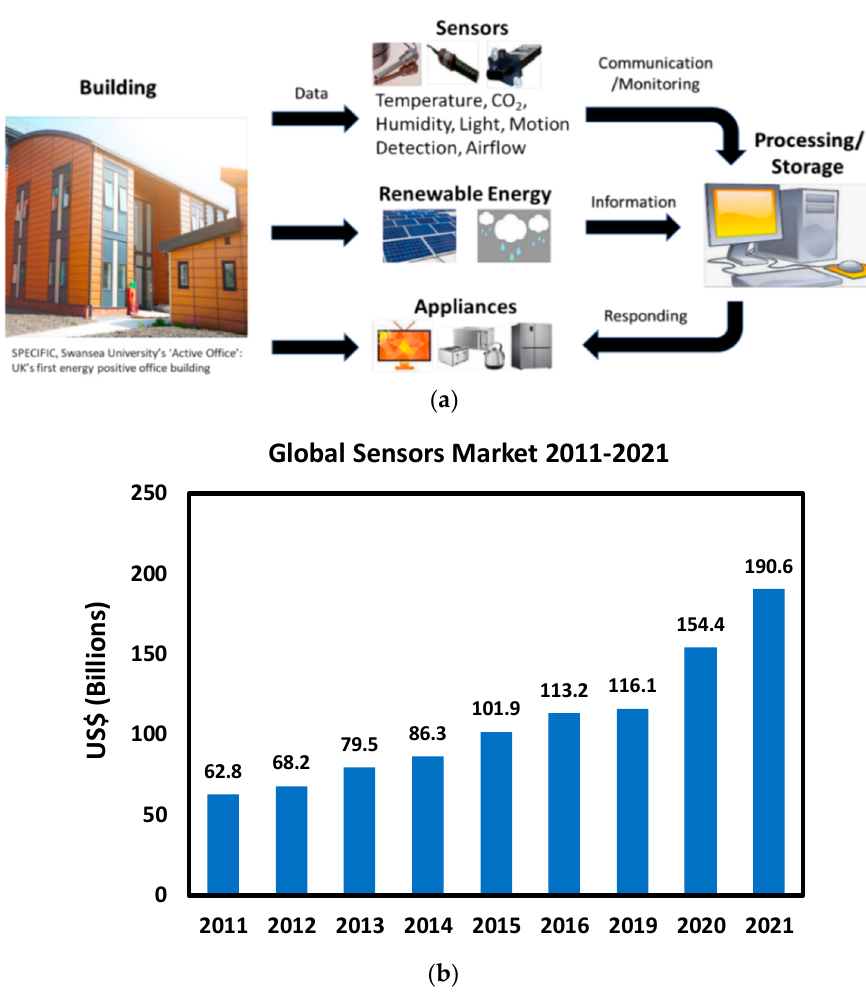
Figure 1. ( a ) Overview of sensing and environmental monitoring in buildings ( b ) Global sensors market growth (in billions of dollars) from 2011 to 2021 [17].